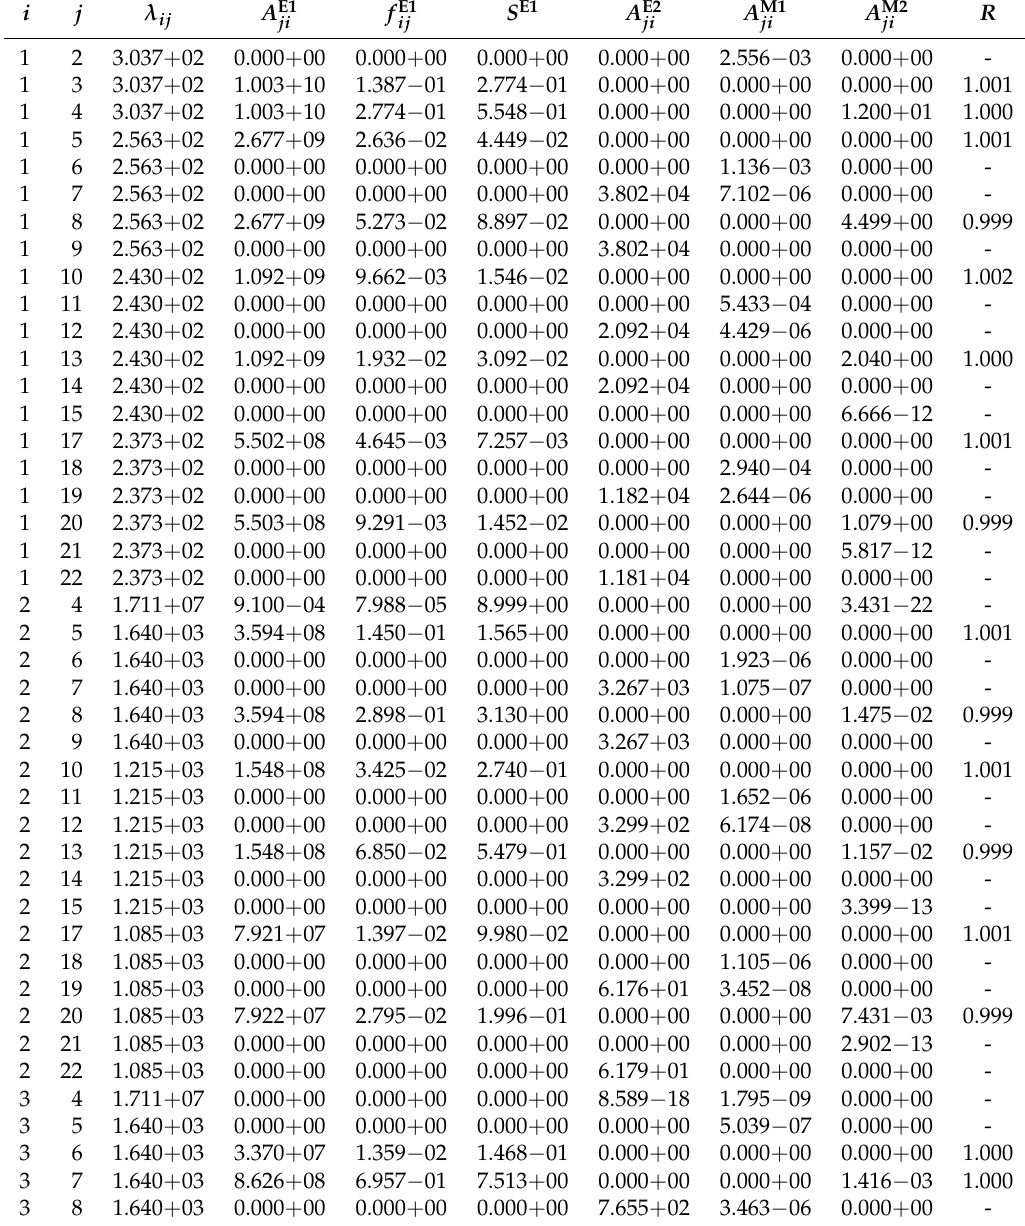
Table 2. Transition wavelengths ( λ ij in Å), radiative rates ( A ji in s − 1 ), oscillator strengths ( f ij , dimensionless), and line strengths ( S , in atomic units) for electric dipole (E1), and A ji for E2, M1 and M2 transitions in He II. The last column gives the ratio R of A (E1) from our GRASP calculations and those available in the CHIANTI database. ( a ± b ≡ a × 10 ± b